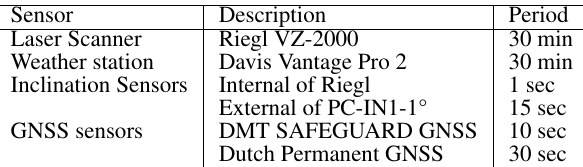
Figure 2. Point cloud of the area of interest from 20/02/2020, 01:00 with reference surfaces marked by letters A-D (compare Table 2) and location of GNSS sensors on the roof of the container and in the dunes (MON 1 - 7). Sensor